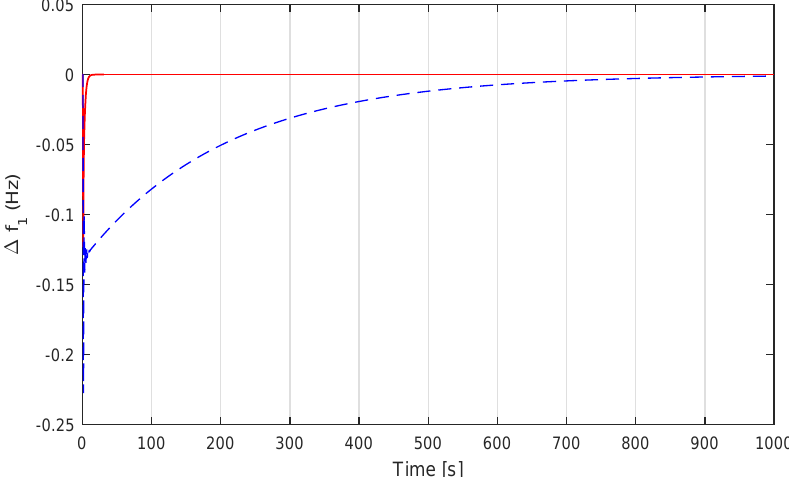
Figure 12. The Compared responding curves ∆ f 1 of V2G system subjected to SOC(solid: proposed, dashed: